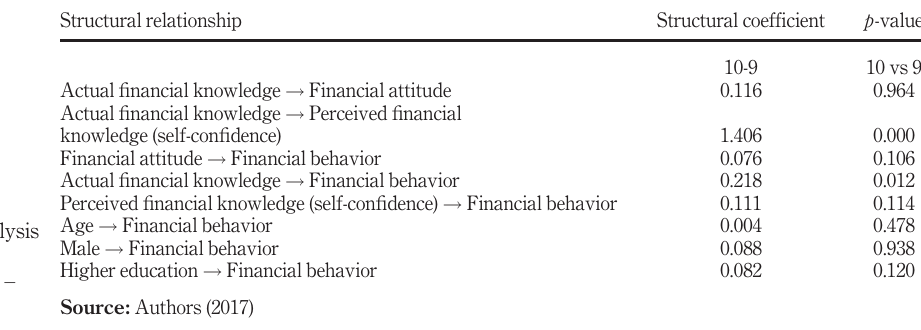
Table XII. Multi-group analysis – PLS-MGA – Groups 9 and 10 –